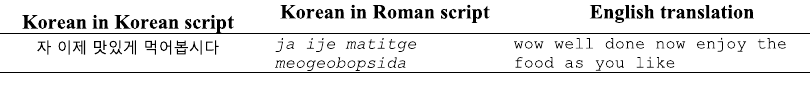
Table 4 Languages and scripts used in the